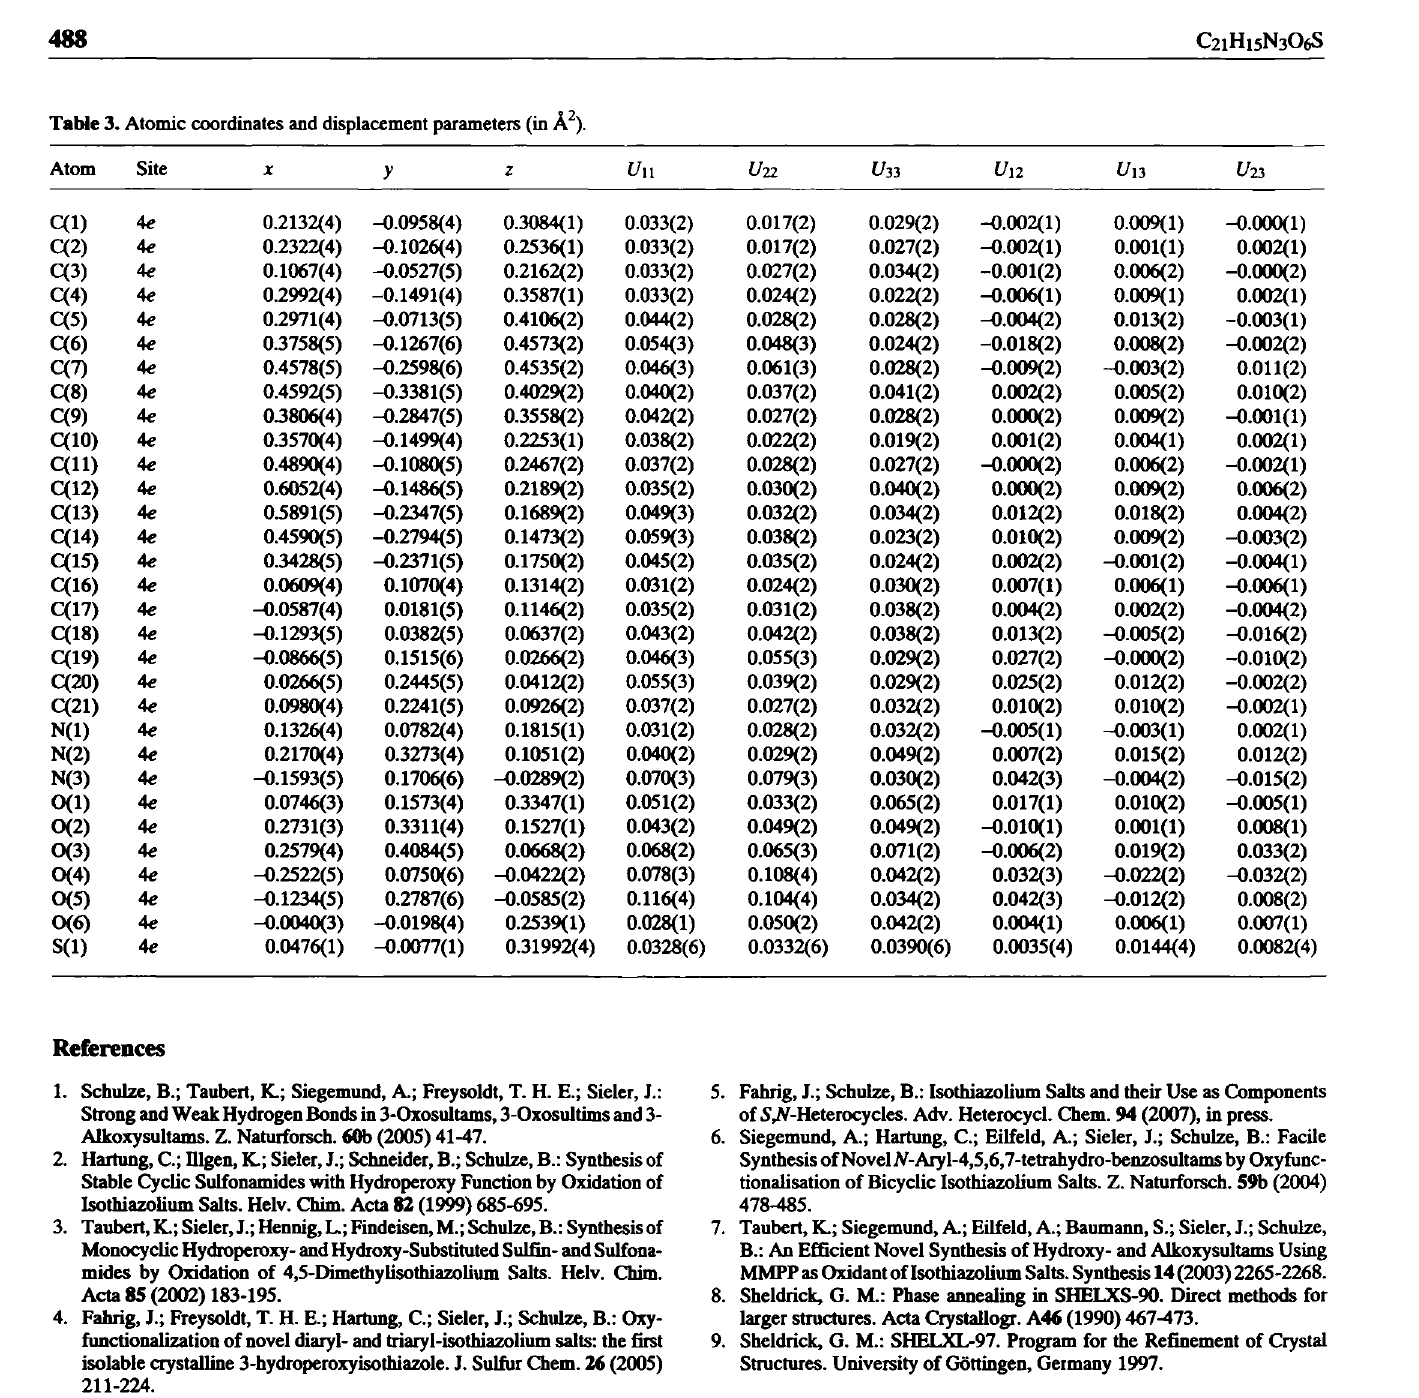
Table 3. Atomic coordinates and displacement parameters (in Ä 2